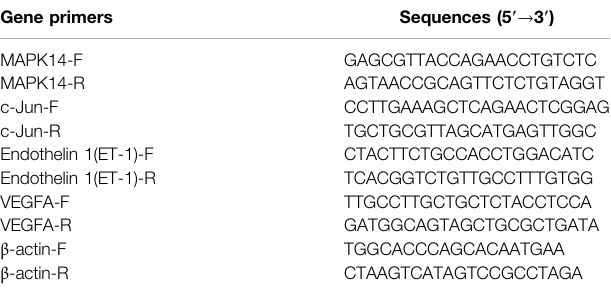
Frontiers in Physiology |